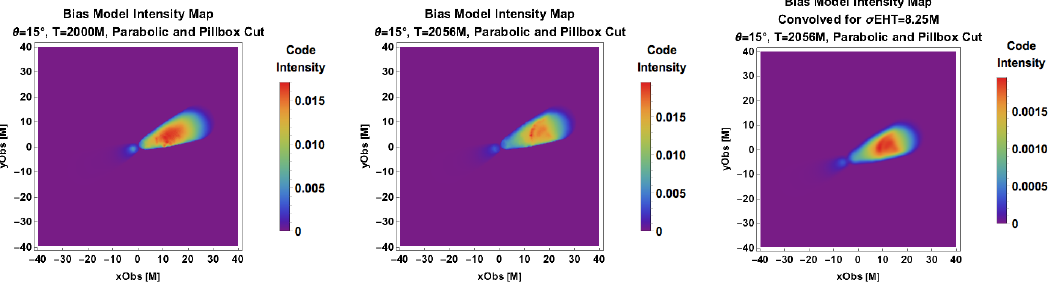
Figure 6. Jet intensity maps viewed at a 15 ◦ observer angle for a simulation where points away from the region 0.5 | z | > x 2 + y 2 > 20 have been excised to isolate the jet and counterjet for the N = 0 bias model. The left map is taken at observed time T = 2000 M , the middle map shows significant variation in the form of an increasingly ordered substructure at T = 2056 M , and the right map displays how the structure is degraded by convolution with a σ = 8.25 M Gaussian